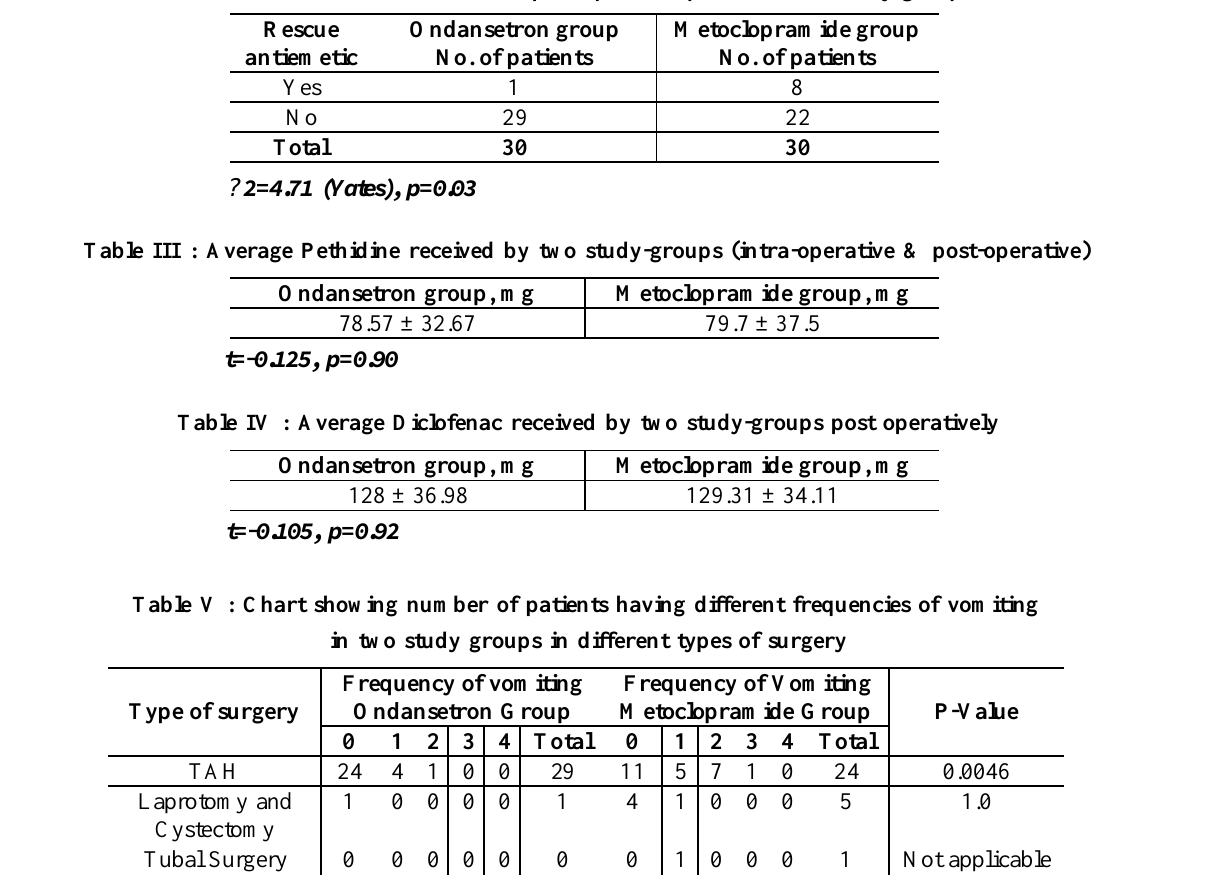
Table II : Rescue antiemetic in post-operative period in two study-groups